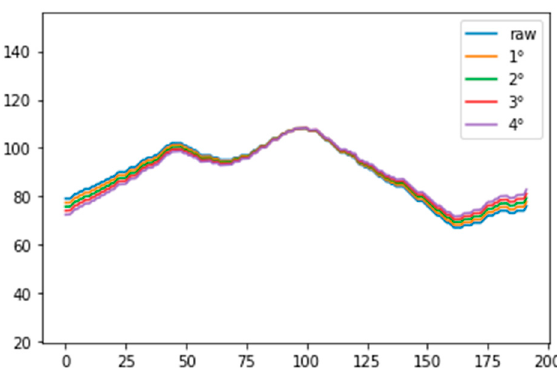
Figure 32. The e ff ect of rotation on a skyline. Figure 32. The effect of rotation on a skyline.